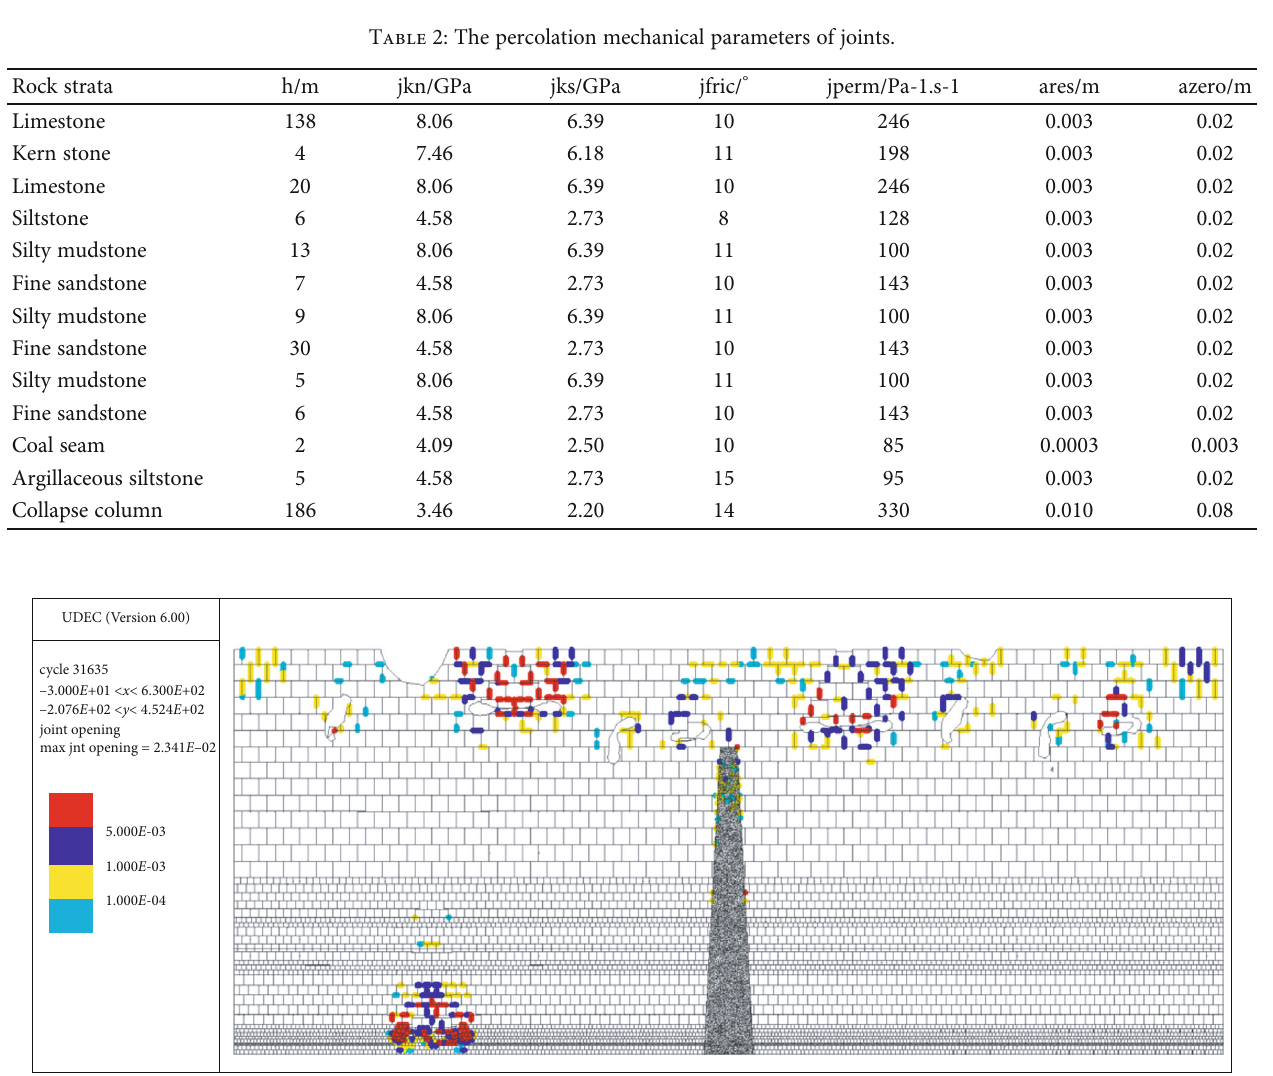
Figure 4: The mining-induced fracture fi eld (the mining distance is